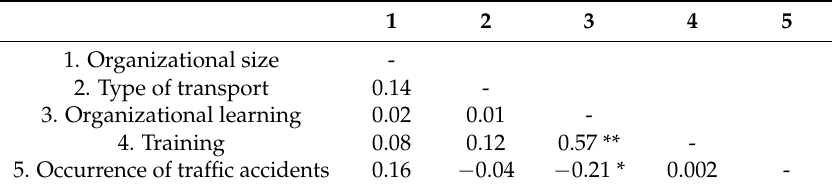
Table 2. Correlations among the variables included in the